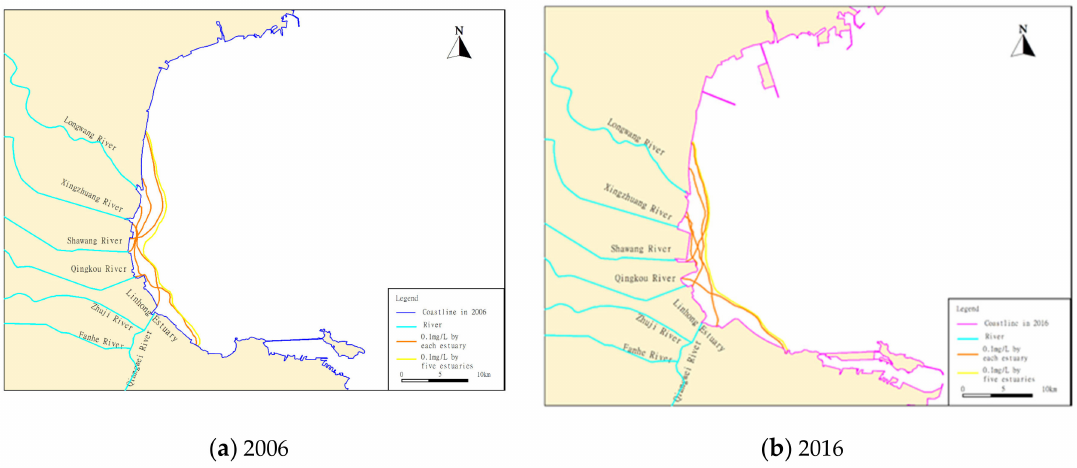
Figure 10. The comparison of the COD concentration contour lines of separate discharge by the five estuaries and concurrent discharge by the five estuaries of Haizhou Bay in 2006 and 2016.